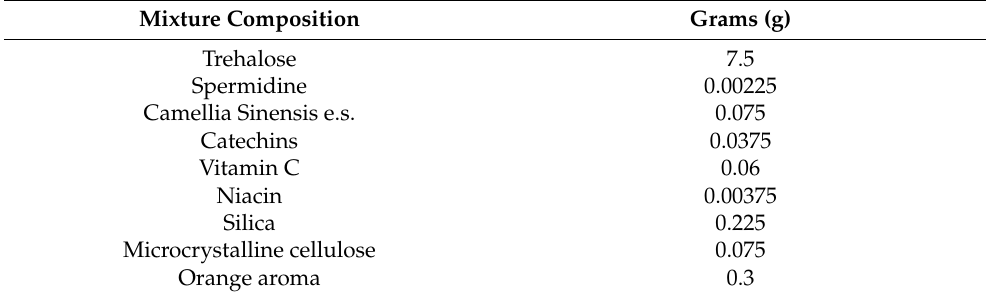
Table 1. Mixture